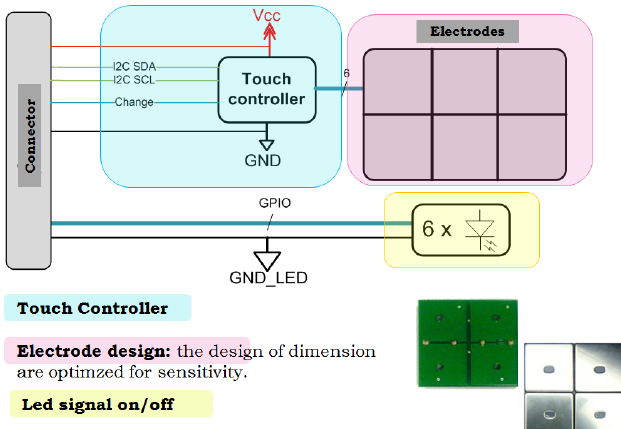
Fig. 9. Block scheme of the designed Touch detection board for up to 6 capacitive tactile sensors. On the bottom right the prototype with 4 electrodes with the front metal panel and the PCB for reference electrodes